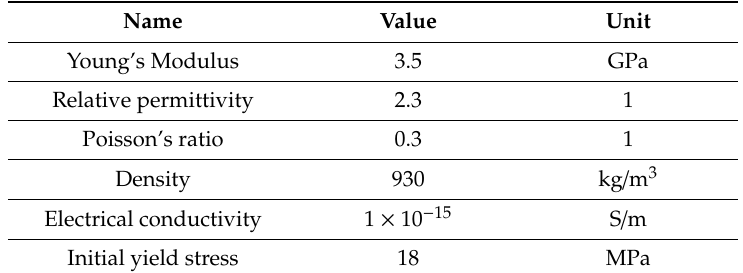
Table 1. Material parameters for XLPE